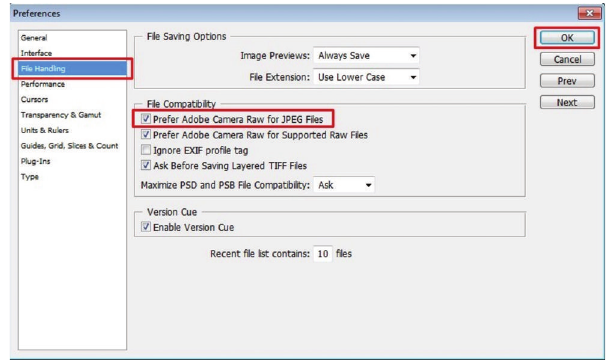
Figure 3: Change “settings” in photoshop (Edit > Preferences > File Handling) to open JPEG files in ACR. Note the red boxes in the figure. Follow them for an easy